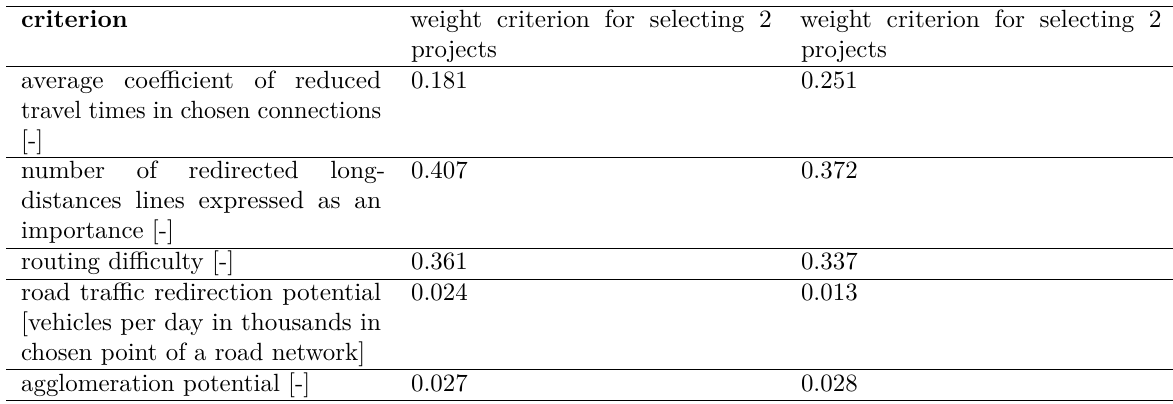
Table 2. Weight criteria set by STEM method for cases of selecting 2 and 4 projects, source: